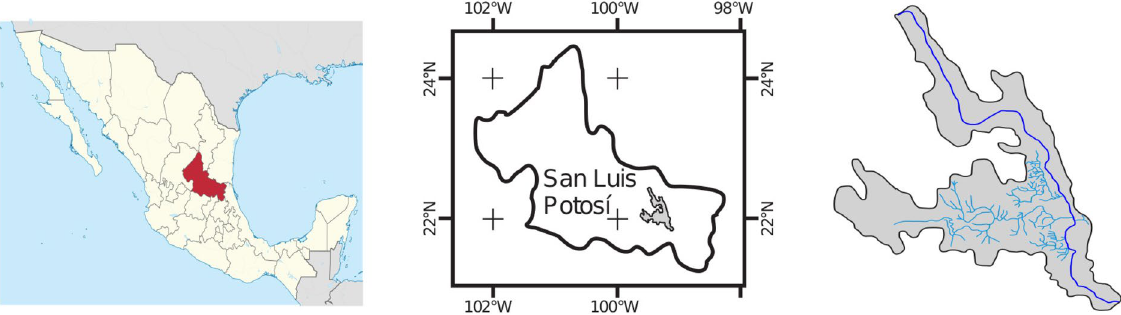
Figure 1. Location of the study zone. The maps were designed with Inkscape 1.0.2 (http:// inksc ape. org), based on OpenMaps.